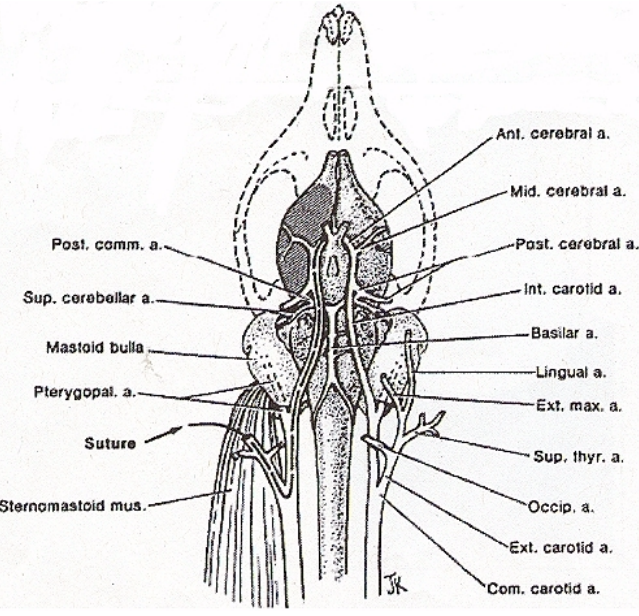
Figure 5. Diagram displaying the rat carotid artery (a) territories and the middle cerebral artery monofilament technique. Branches of the external carotid artery which is dissected for monofilament introduction of the suture, feed mastication and neck muscles, pharnx, tongue, salivary glands, face, external and middle ear and the meninges. Adapted from Zea Longa et al. , 1989